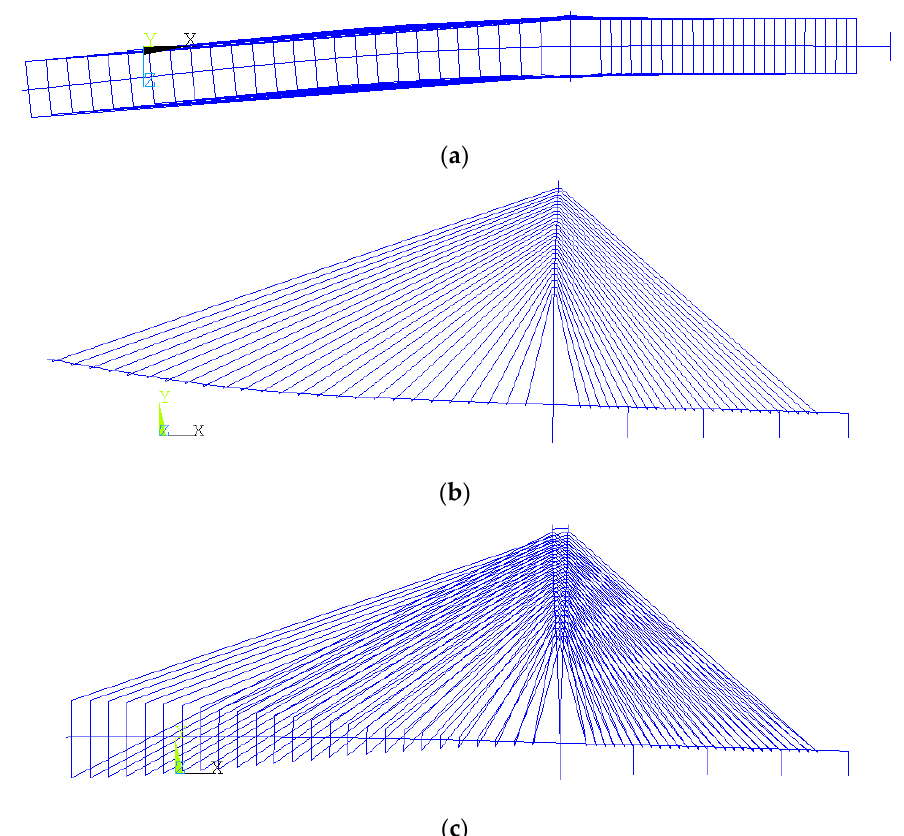
Figure 3. Fundamental modes of construction state. ( a ) Lateral (0.1869 Hz); ( b ) vertical (0.2688 Hz). ( c ) torsional (0.6030 Hz).